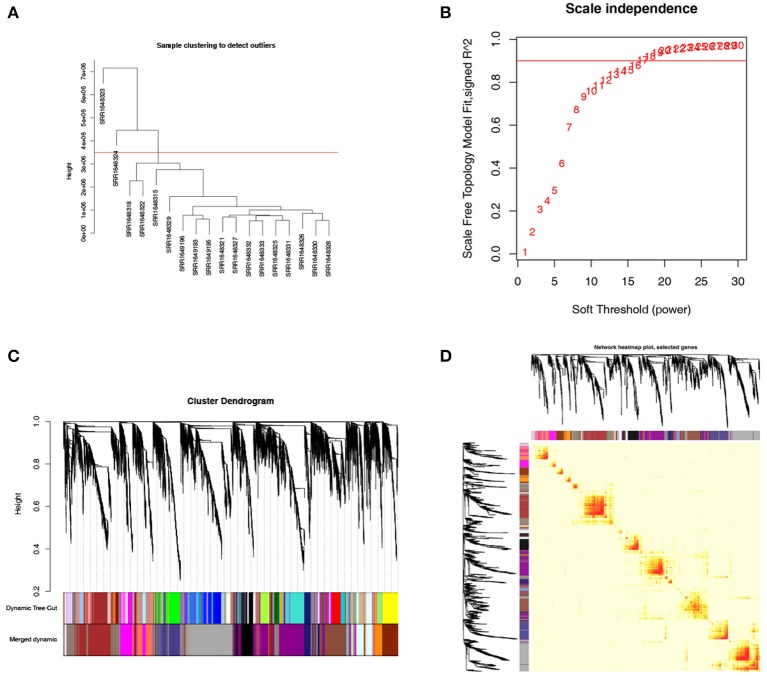
Weighted gene co-expression network analysis (WGCNA) of genes in natural killer T-cell lymphoma (NKTCL). (A) Cluster dendrogram displays the relationship between NKTCL samples. (B) Analysis of the scale-free fit index for various soft thresholding powers (β). (C) Hierarchical cluster tree showing co-expression modules identified by WGCNA. (D) Heat map plot show the topological overlap matrix (TOM) among all genes. Light color shows low overlap, and red color indicates higher overlap. The left side and the top side show the gene dendrogram and module assignment.